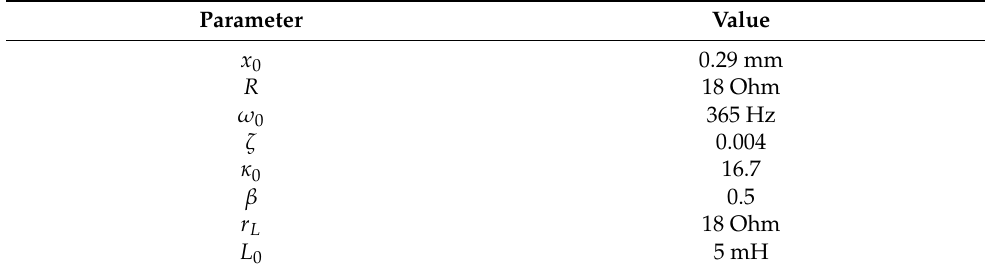
Table 1. Parameter values of the electro-magneto-mechanical oscillator